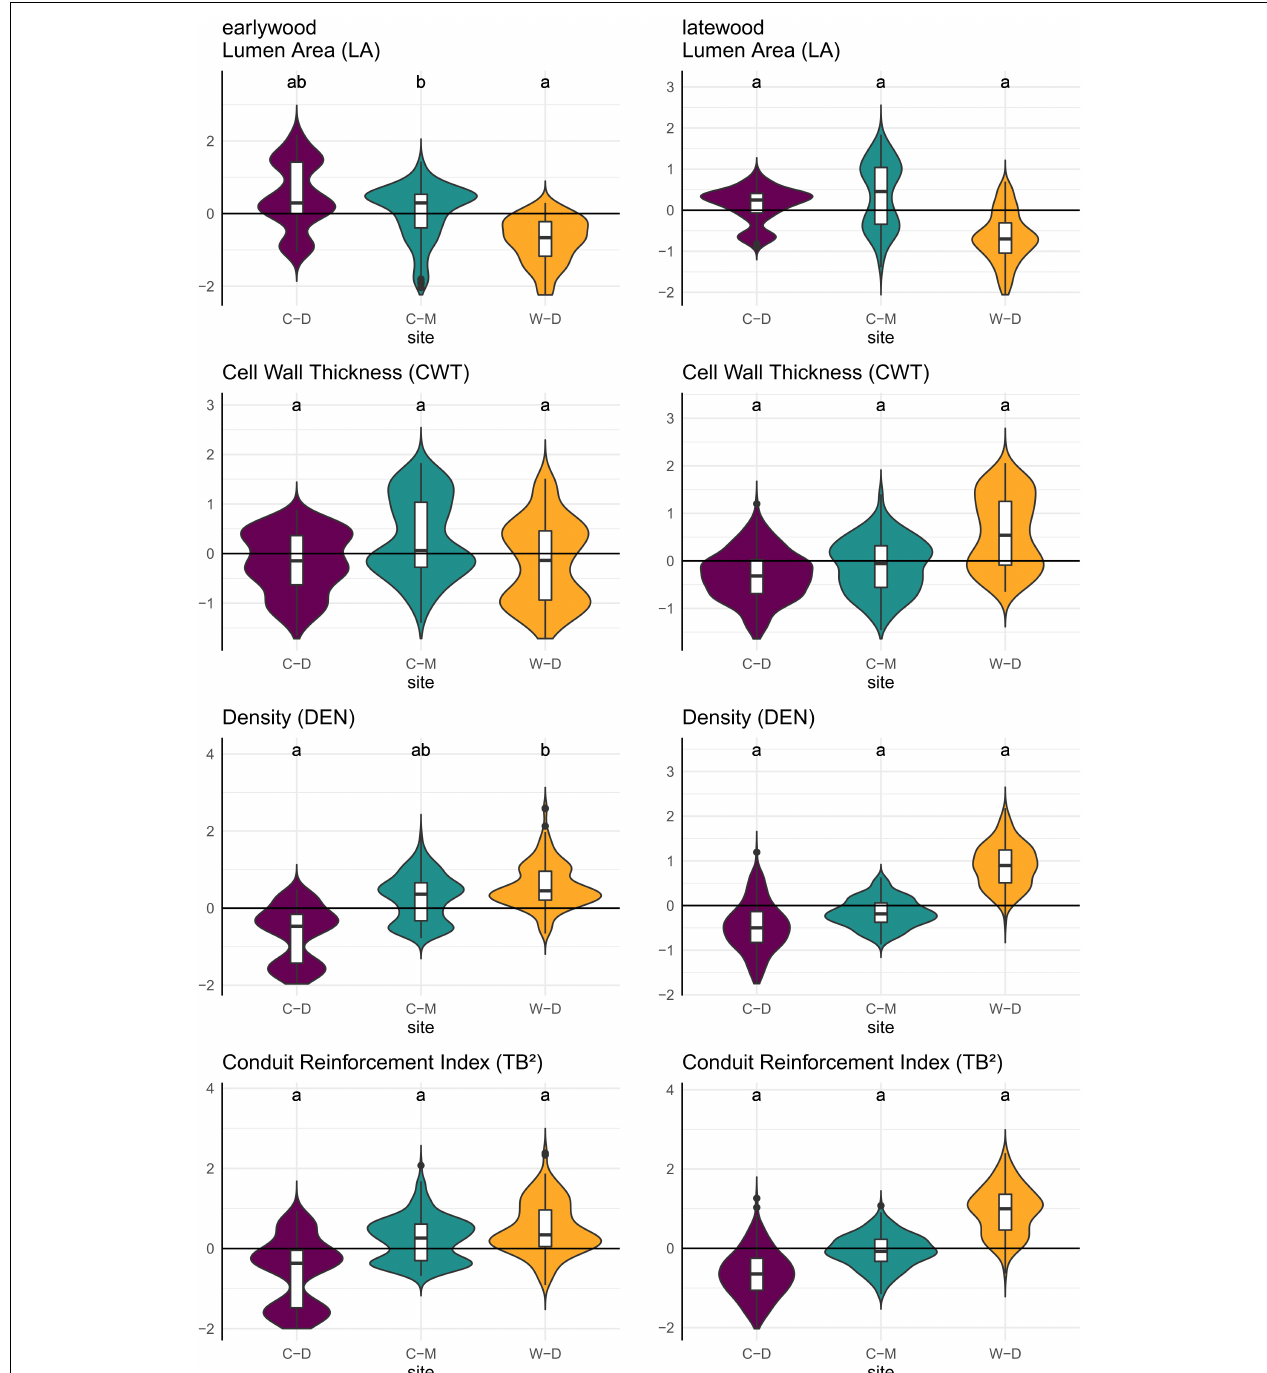
FIGURE 5 | Violin plots combined with boxplots of predicted relative trait values ( y -axis), based on linear mixed-effects models as described in the methods. Small letters indicate significance groups based on pairwise comparison with a significance threshold of p = 0.05. Purple = Brooks Range (C-D), Green = Denali National Park (C-M), Orange = Bluff